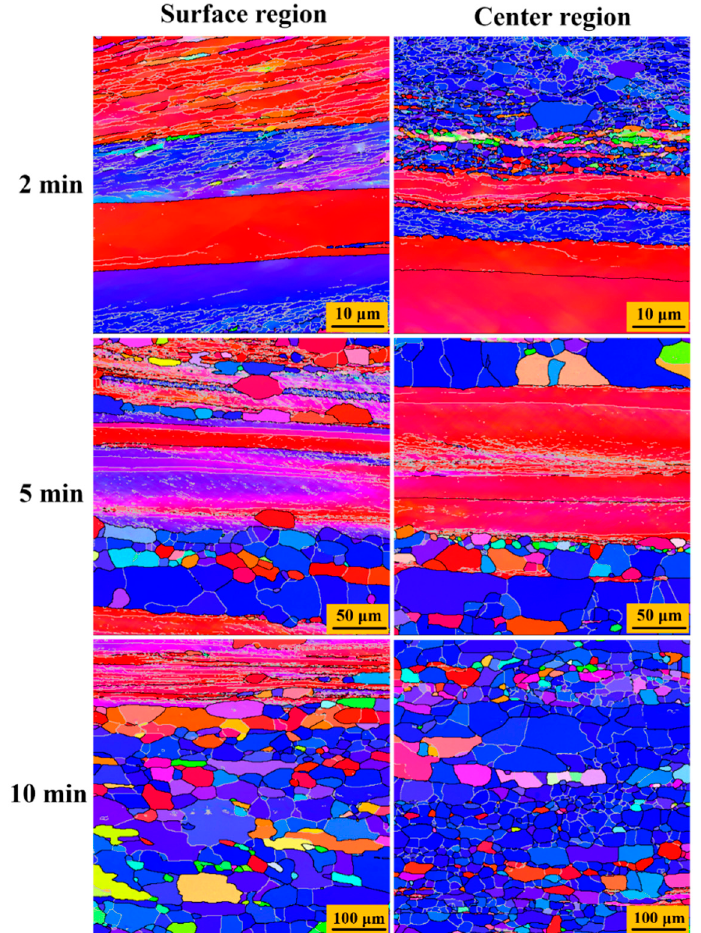
Figure 7. The evolution of the microstructure of the 87% UR sample annealed for different times at 1065 °C. Step size 0.1 μ m for 2 min, step size 0.6 μ m for 5 min, and step size 1.5 μ m for 10 min.